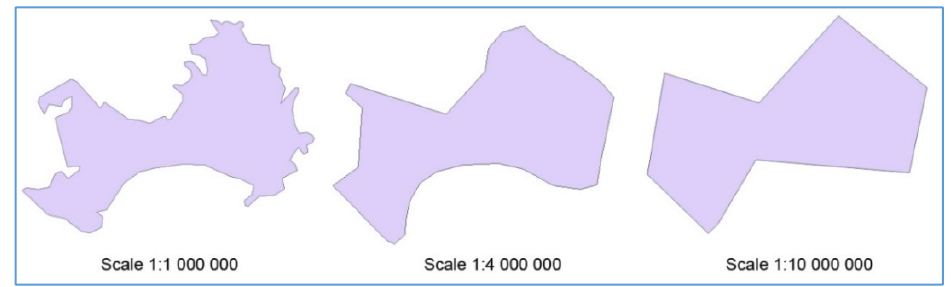
Figure 1. The representation of vector data at different scales.